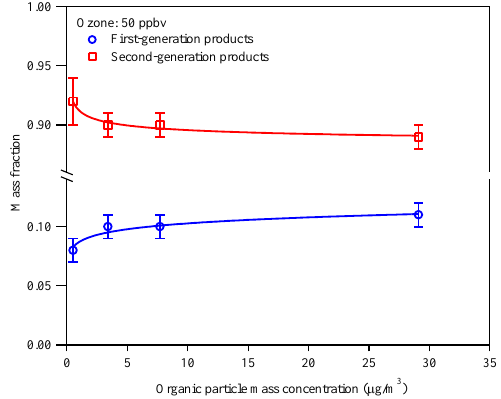
Fig. 6. Mass fractions of first- (blue) and second-generation (red) products for increasing organic particle mass concentration. The abscissa of organic particle mass concentration was measured using the AMS. The ordinate of mass fraction represents the mass concen- trations of the first- and second-generation products divided by the sum of mass concentrations, all as measured by UPLC-MS. In these experiments, the β -caryophyllene concentrations varied from 1.7 to 46.4ppbv, generating particle organic mass concentrations from the low to high values represented in the figure. The ozone concentra- tion was 50ppbv. Error bars represent ± 1 standard deviation of the mass percentages of three replicate experiments. Lines are shown to guide the